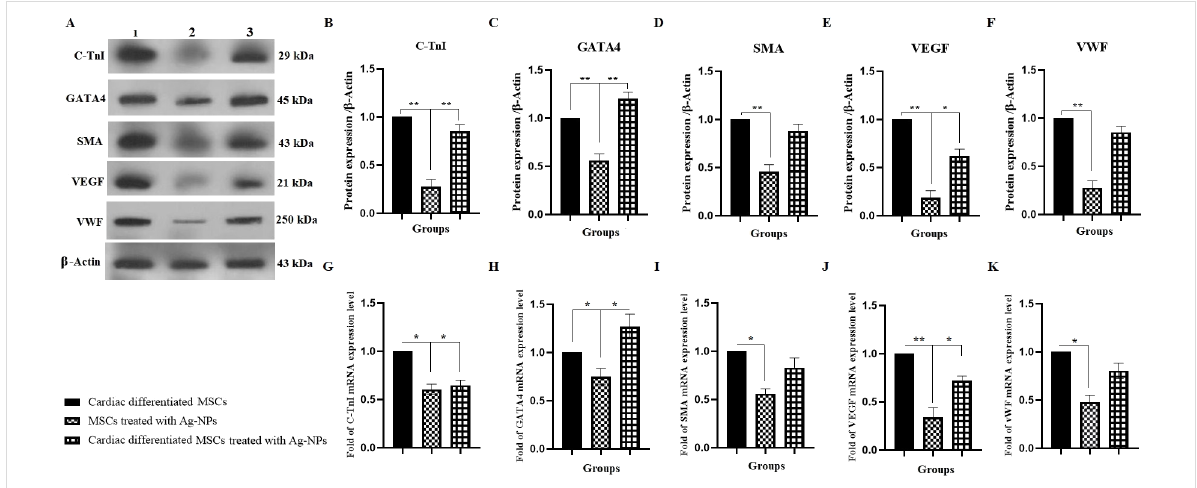
Figure 7: Effect of Ag-NPs on C-TnI, GATA4, SMA, VEGF, and VWF protein and gene expression in cardiomyogenically differentiated BM-MSCs. (A–F) Protein and RNA were extracted from group I (cardiomyogenically differentiated BM-MSCs without Ag-NP treatment), group II (BM-MSCs in the presence of 2.5 µg/mL Ag-NPs), and III (cardiomyogenically differentiated BM-MSCs in the presence of 2.5 µg/mL Ag-NPs) as described in methods section and was subjected to western blotting; (* P < 0.05 and ** P < 0.01) and real-time PCR (G–K); (* P < 0.05 and ** P < 0.01), respectively.